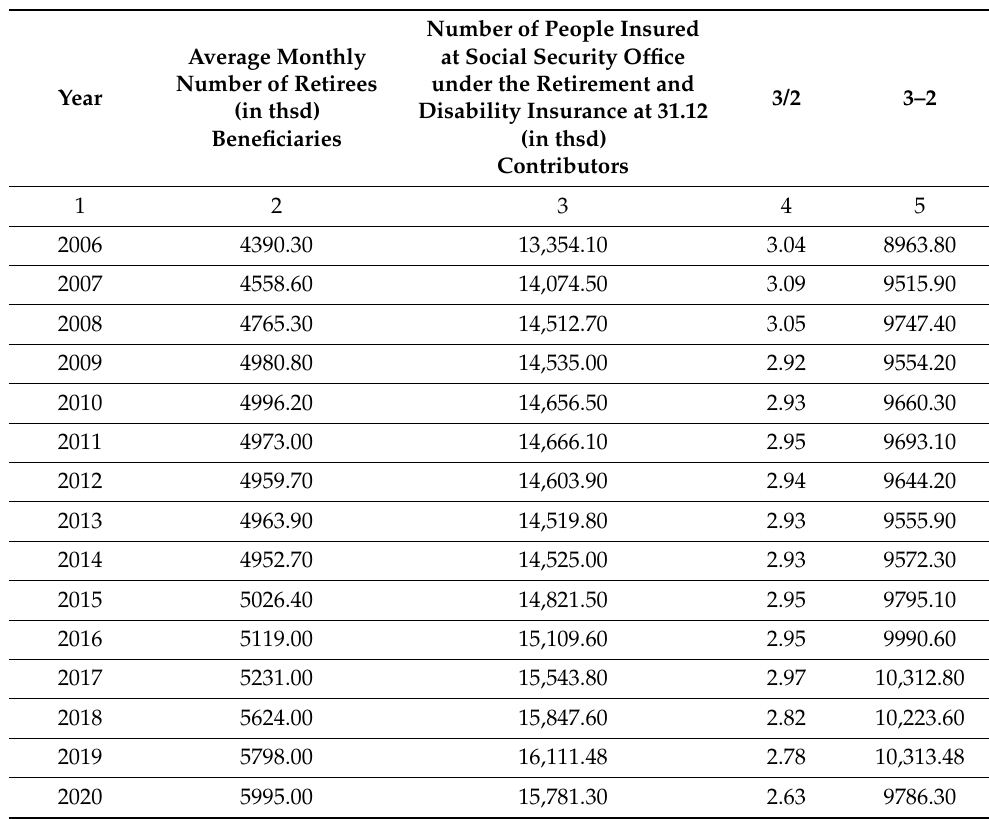
Table 1. The number of contributors and beneficiaries of the Polish pension insurance system